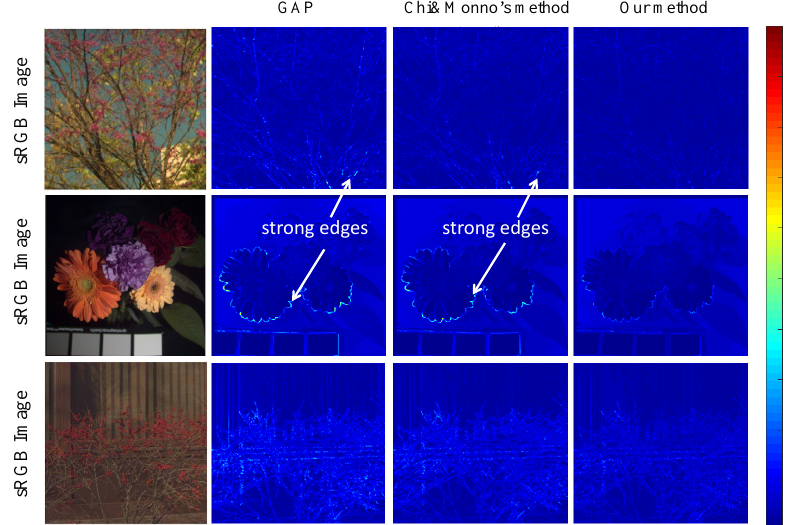
Figure 12. Reconstruction spectral error of multi-spectral images in our database (the 1st row), CAVE spectral database (the 2nd row), and Harvard’s database (the 3th row) using a GAP camera, Chi and Monno’s method and our mosaic camera (see Figure 11). Please zoom in and see sharp edges in gray